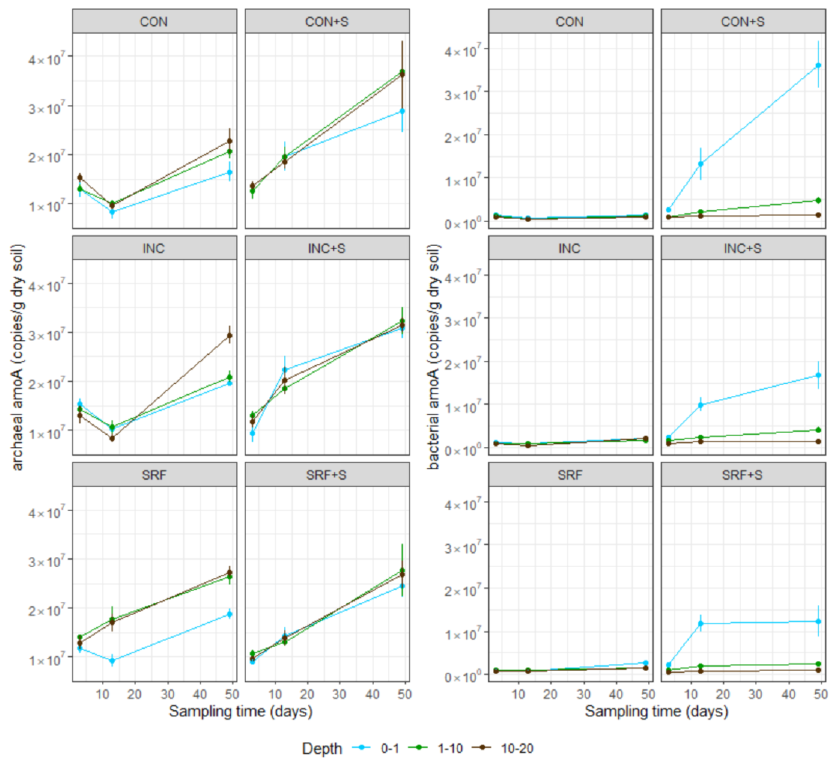
Figure 4. Dynamic of crenarchaeal (AOA) and bacterial (AOB) amoA gene abundance in CON (control), INC (straw incorporated in 0–10 cm soil layer) and SRF (straw applied at the soil surface) soil treatments in presence/absence of slurry (S) at three sampling depths (cm). Averages and standard errors of 4 replicates are shown.